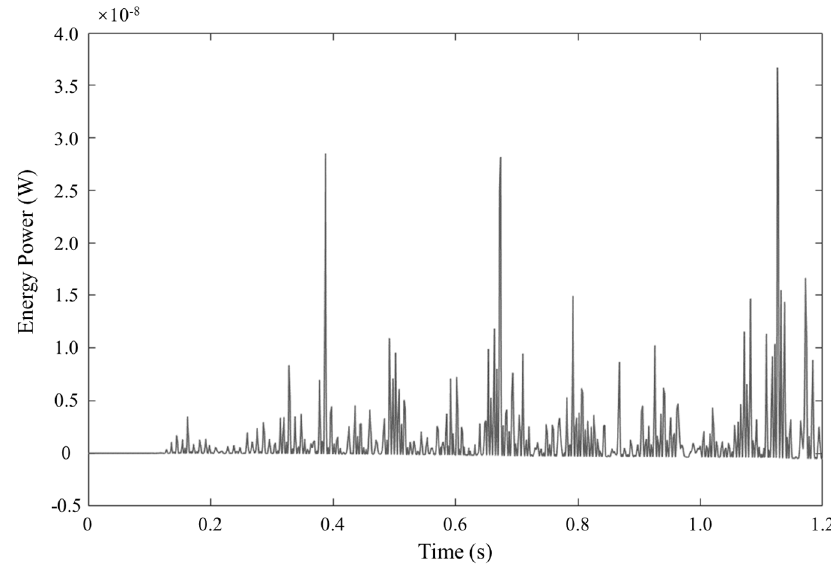
Figure 16. Energy harvesting power.